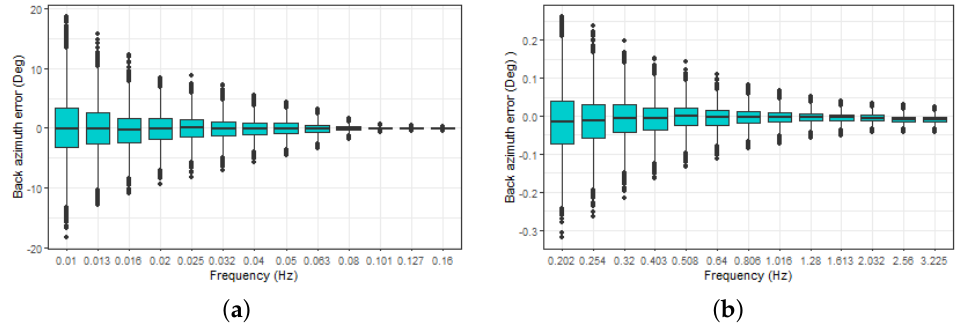
Figure 10. Back azimuth error (bias) resulting from the estimation method and the uncertainty propagation. The box contains 75 % of the Monte Carlo sampled values for back azimuth error and the error bars range from the lower fence to the upper fence (see [49] for the definition of boxplots). ( a ) Frequency lower than 0.2 Hz. ( b ) Frequency higher than 0.2